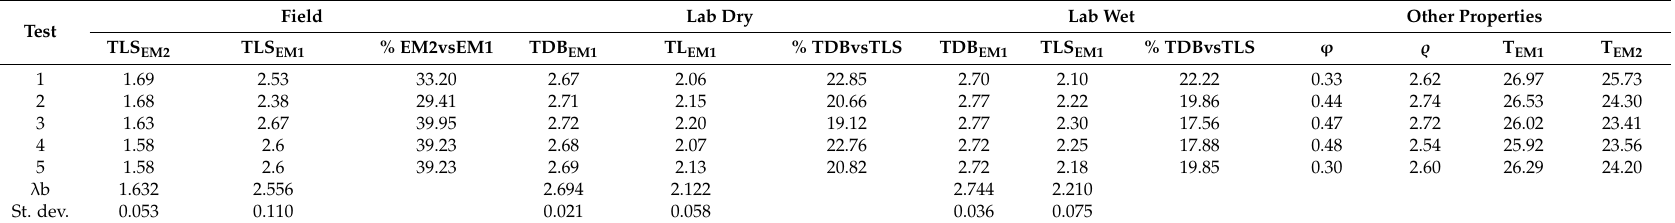
Table 3. Results from field and laboratory activities. Keys: TLS (Transient Line Source methods) and TDB (Transient Divided Bar technique), EM2 and EM1, fault and rock respectively. The symbol percentage indicates the percentage between two measurements of thermal conductivity. T is the temperature (°C), φ indicates the porosity (% vol), and ρ defines density (g/cm 3 ). λ b, is the bulk of thermal conductivity (W m − 1 K − 1 ). St.dev., the standard deviation of λ b.